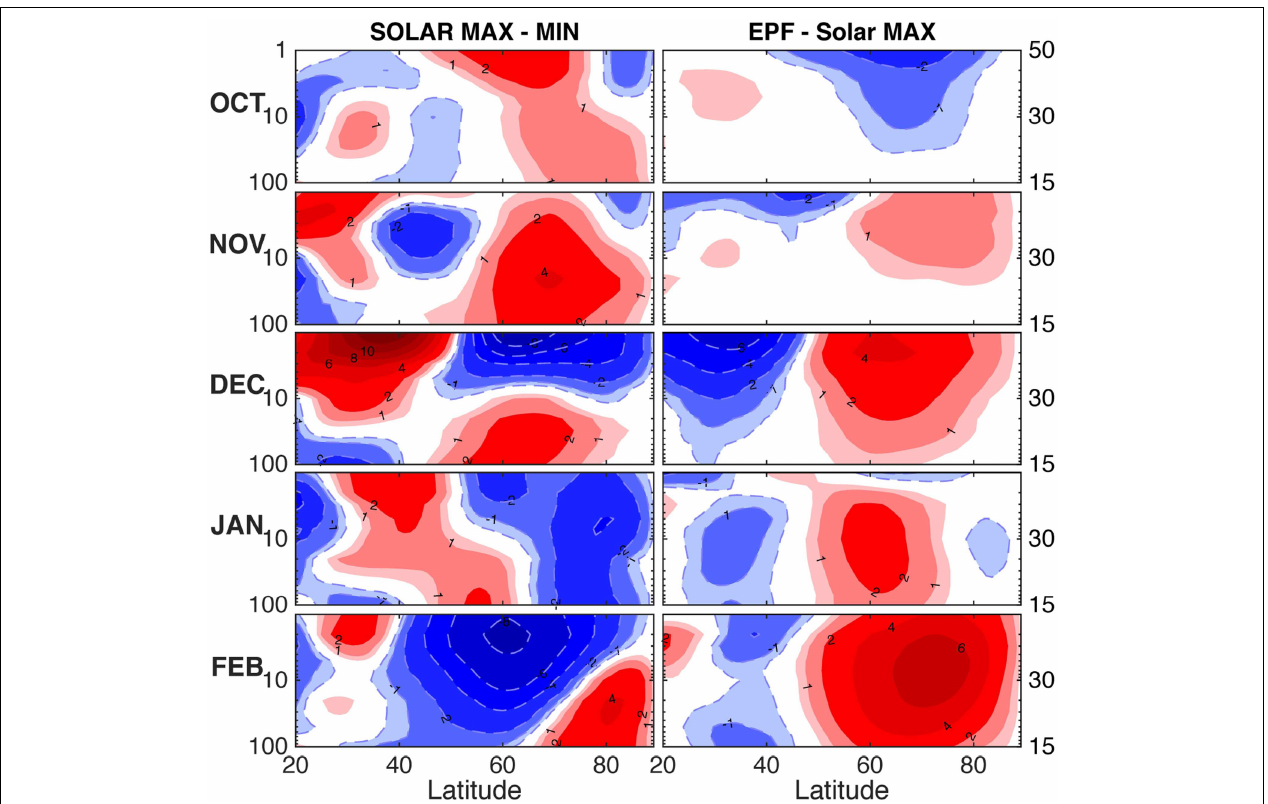
FIGURE 1 | Monthly mean zonal mean zonal wind composite differences. Left: Solar maximum–Solar minimum. Right: Energetic Particle Forcing (EPF)–Solar maximum. Contour lines are shown for ± 0.5, ± 1, ± 2, ± 4, ± 6, ± 8, ± 10, and ± 12 m/s. Negative values are shown in blue and indicated with additional dashing. The vertical axis on the lefthand side is pressure [hPa], the approximate altitude in [km] is given on the righthand